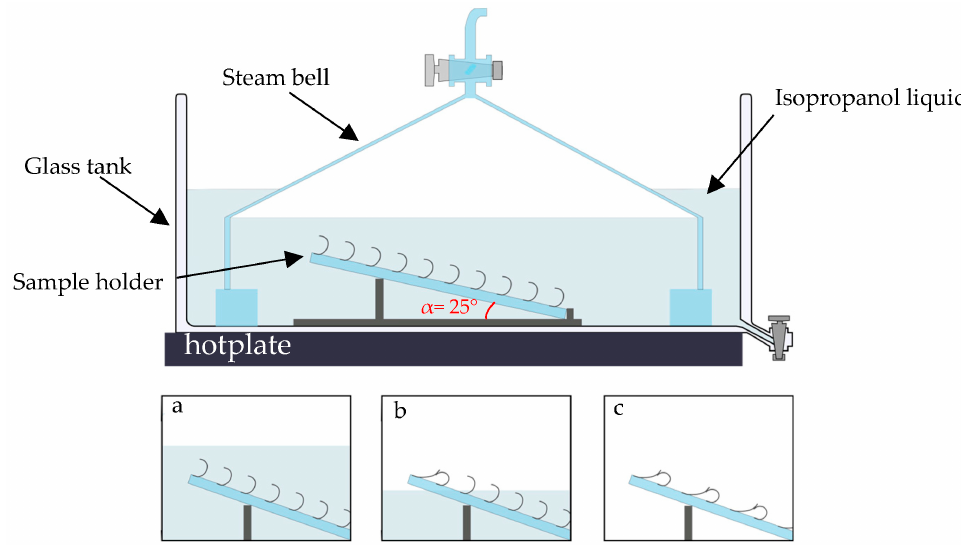
Figure 4. The drying setup placed on a hotplate consisting of a glass tank with a dispenser and steam bell. The sample holder is placed inside, and this allows us to use differently angled positions. The gradual movement of the isopropanol liquid and forming of the paired shutters are shown in ( a – c ). The pairing phenomenon was first observed in our study at d Al2 = 88 nm [16]. Among the others, the pairing the two blades is used to study the role of attractive Casimir forces.